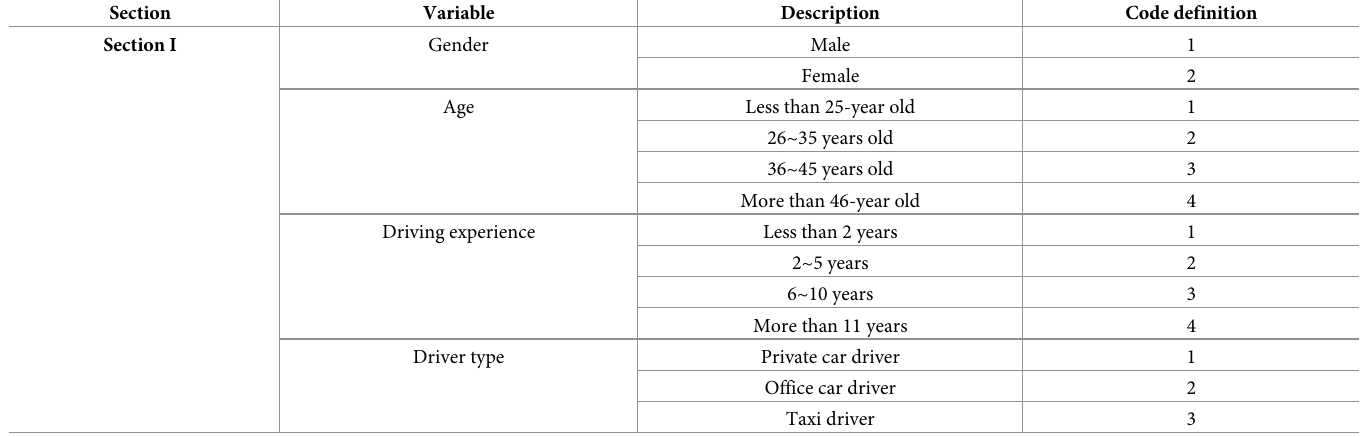
Table 1. Definitions of socio-demographic